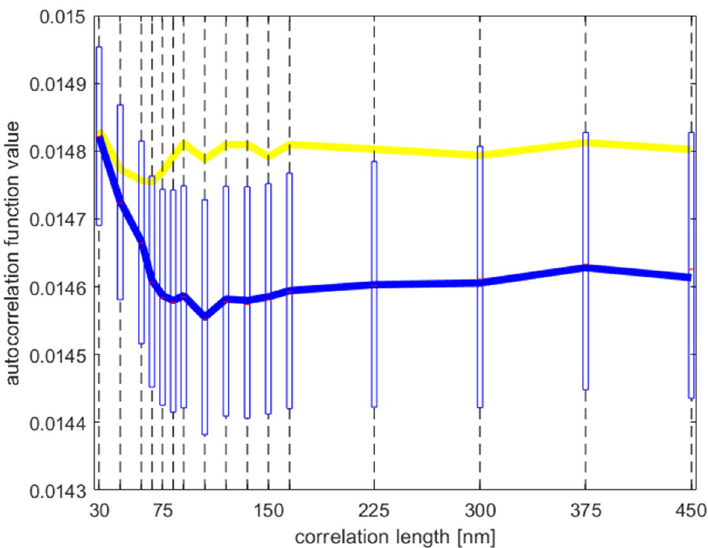
Figure 14. Autocorrelation function (as derived from the dark-field extinction coefficient) for the 50 nm disk sample (blue), as well first and third quartile bounds, which reveal the noisy nature of this signal. The yellow graph show the autocorrelation function for the 150 nm disk sample. Notice how the initial slope is shallower than for the 150 nm autocorrelation